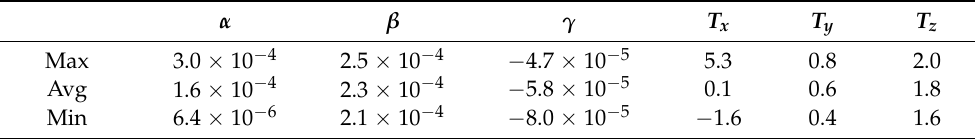
Table 1. ICP registration results.